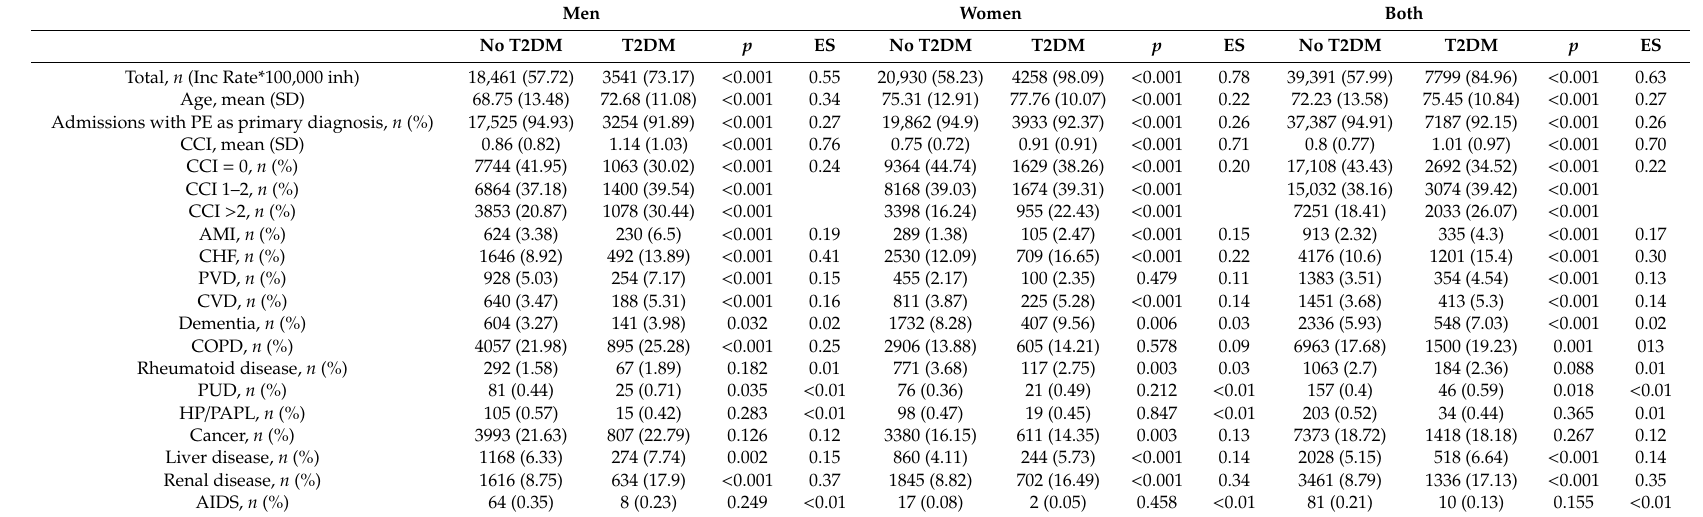
Table 1. Incidence rates and clinical characteristics among patients hospitalized with pulmonary embolism according to sex and type 2 diabetes (T2DM) status in Spain